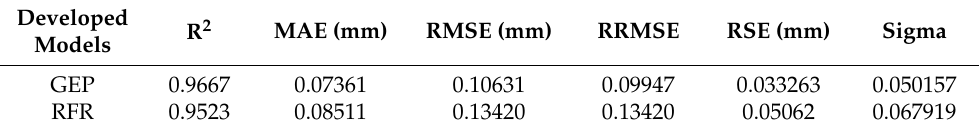
Table 7. Summary of statistical error checks and performance index.